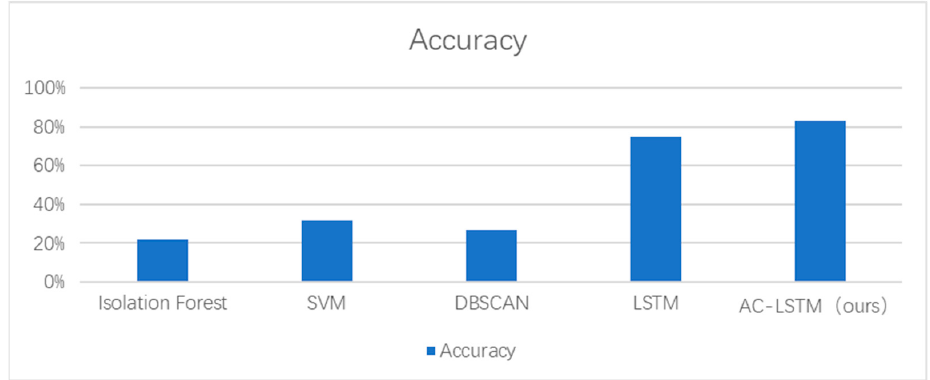
Figure 8. Comparison of accuracy of abnormal point detection methods with ours.